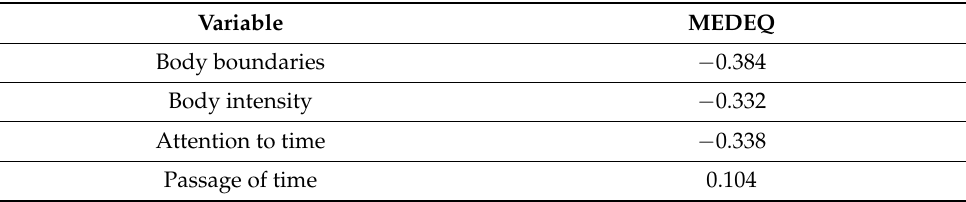
Table 7. Correlations (all p > 0.05) between meditation depth (MEDEQ) on the one hand and subjective time and body boundaries on the other